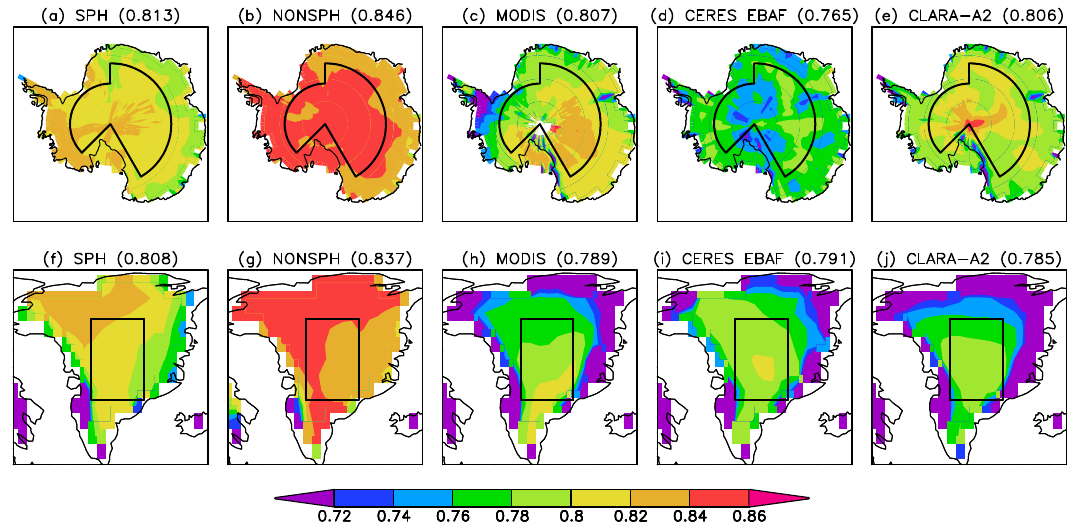
Figure 10. Annual-mean surface albedo (a–e) over Antarctica and (f–j) over Greenland in the SPH and NONSPH experiments and in three observational data sets: MODIS, CERES EBAF, and CLARA-A2. Clear-sky albedos are shown for SPH, NONSPH, and CERES EBAF, and black-sky albedos for MODIS and CLARA-A2. The numerical values given in parentheses are mean albedos averaged over the two regions marked in the figures: central Antarctica (75–90 ◦ S at 0–150 ◦ E plus 80–90 ◦ S at 0–135 ◦ W) and central Greenland (68–78 ◦ N, 33–48 ◦ W). In temporal and spatial averaging, the albedo values are weighted by the clear-sky downwelling solar flux at the surface using modelled values for the SPH and NONSPH experiments and CERES EBAF values for the three satellite data